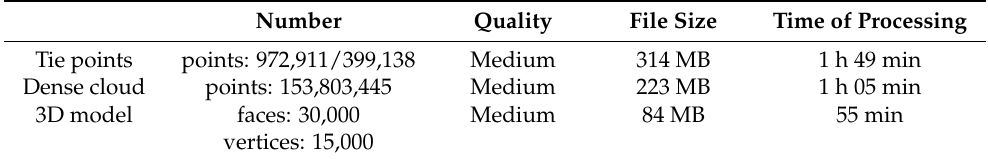
Figure 8. 3D textured model. Source: author, Agisoft. Table 3. Overview of processing results. Source: Agisoft.